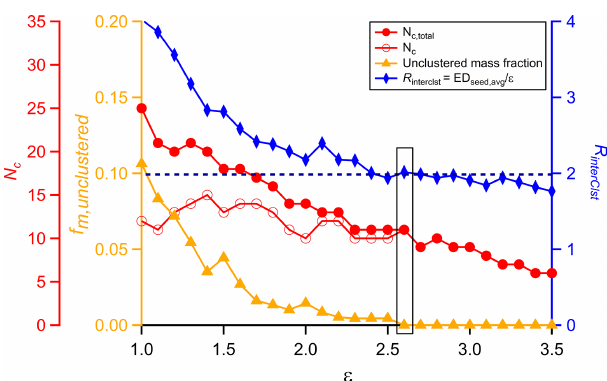
Figure 4. The variation of four parameters, N c , N c , total , f m , unclustered , and R interClst , as a function of the distance crite- rion ε . The black horizontal dashed line guides the judgement for R interClst ≥ 2. The values highlighted by a rectangle are the values corresponding to the optimal ε used for the clustering